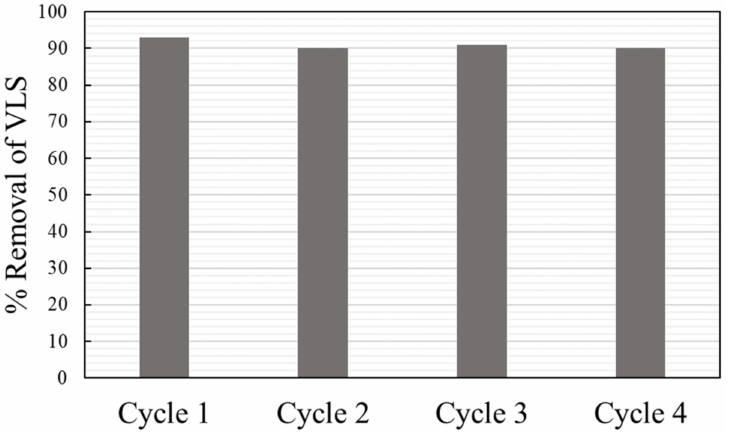
Figure 11. VLS removal for four consecutive runs using 0.25% MoS 2